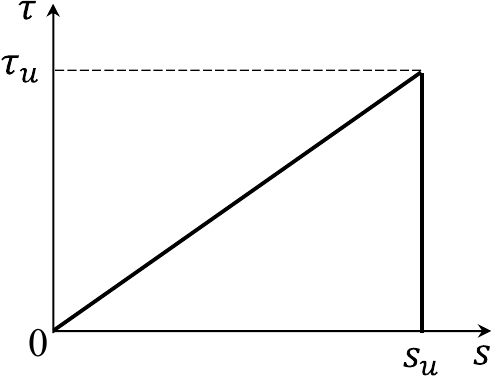
Figure 10. Interface bond–slip model.